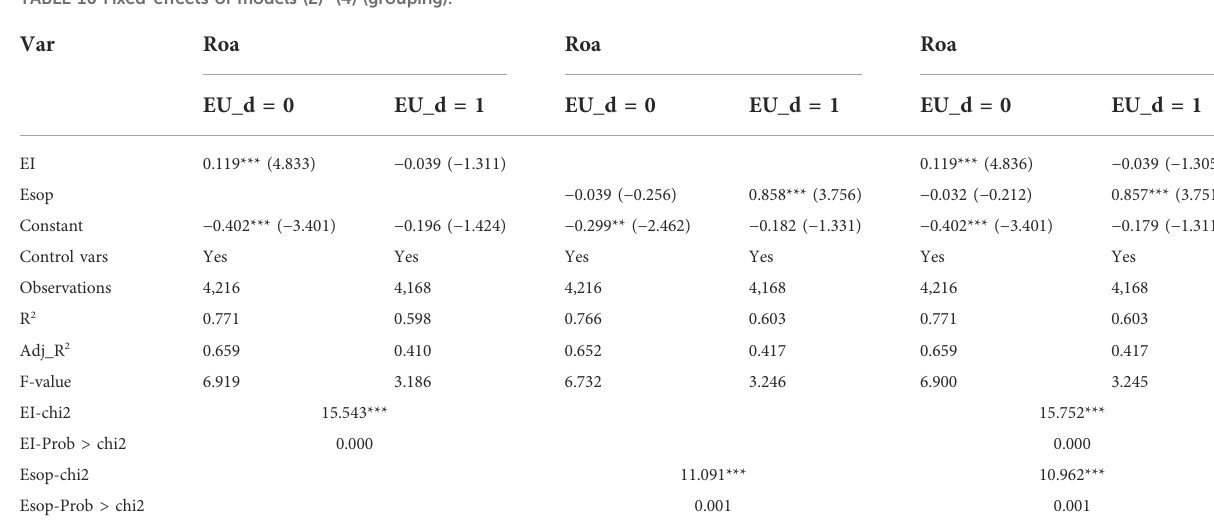
TABLE 10 Fixed-effects of models (2) – (4)